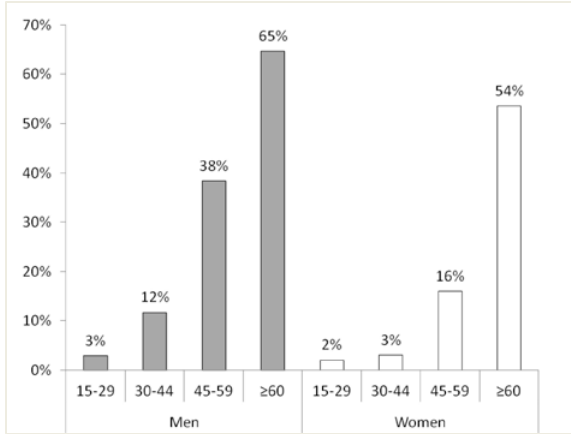
Figure 1: Hypertension prevalence by sex and age